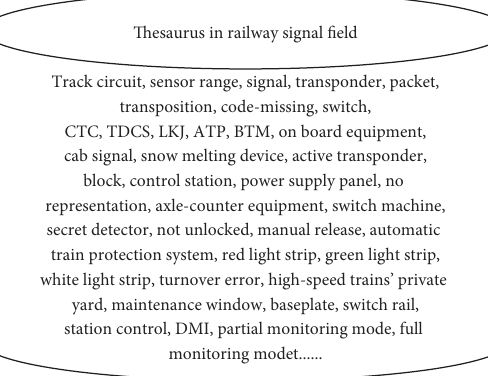
Figure 6: Railway signal domain Thesaurus